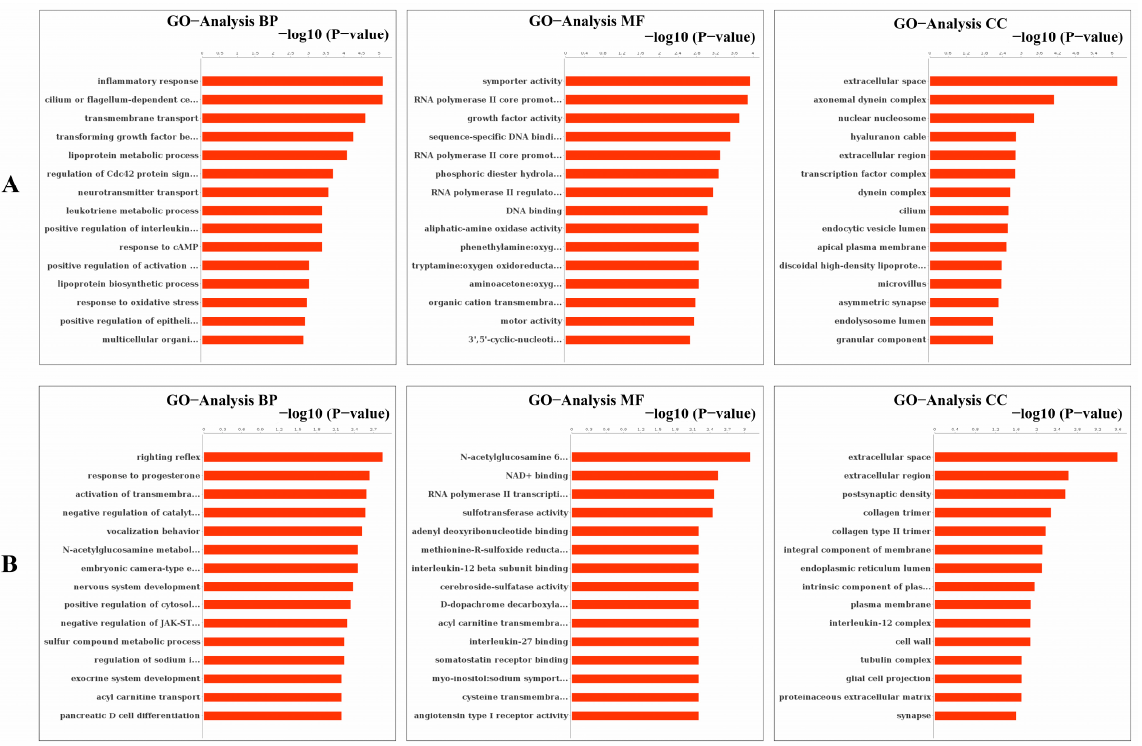
Figure 8. Analysis of GO enrichment in molecular function, cellular component, and biological process. ( A ) Analysis of up-regulated GO enrichment in three ontologies. ( B ) Analysis of down- regulated GO enrichment in three